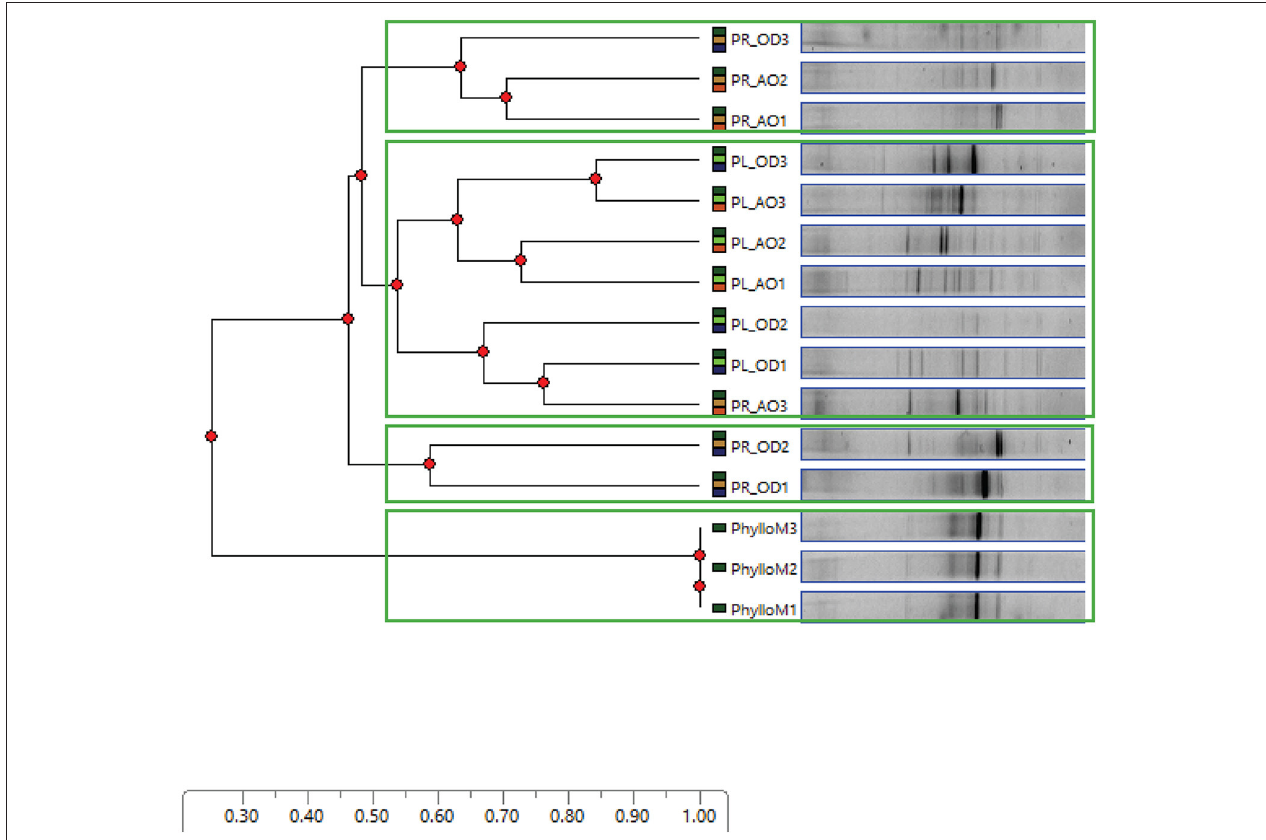
FIGURE 2 | DGGE bands obtained for sunflower endo-phyllosphere bacterial community, developed in MPN culture tubes of leaf strips (PL; ) or root segments-based (PR; ) culture media; UPGMA cluster analysis based on Euclidean distances of DGGE lanes. Each lane represents the bacterial growth harvested from one MPN culture tube, and each culture medium is represented by three MPN tubes (1–3) incubated under ambient oxygen (AO; ) or limited oxygen (OD; ) conditions. PhylloM ( ), DNA extracted from original suspension of plant leaves (1–3).